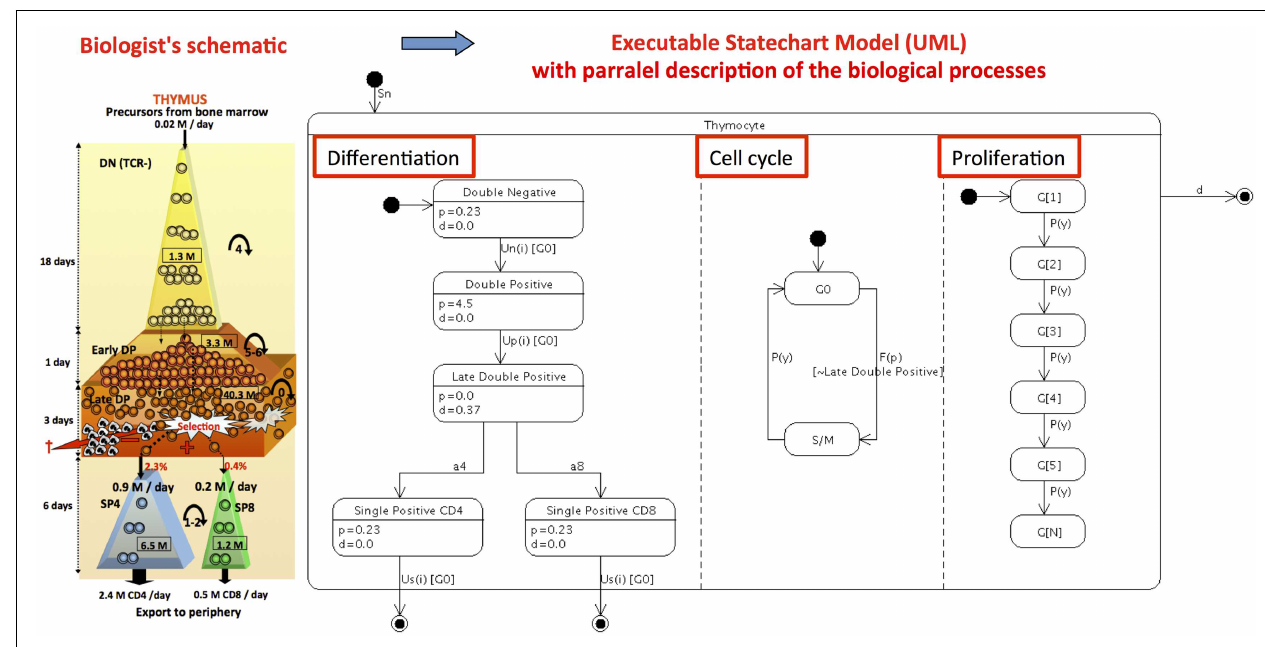
(close circle arrow) and output representing death and thymus exit (open circle arrow) and transitions (oriented arrows). Parallel processes (underlined with red box) as differentiation, cell cycle and proliferation are depicted more explicitly in this representation than with the original 30 mathematical equations. Annotation with the proliferation and death rates values indicated in each state are values from the best scenario observed in the original